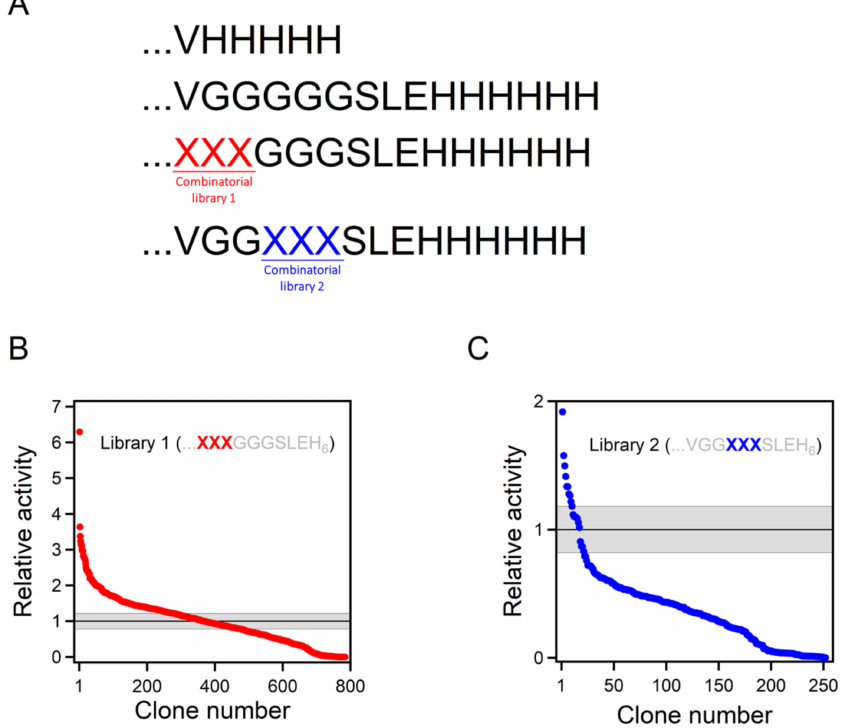
Figure 3. Combinatorial library screening for enhanced Kemp eliminase activity. ( A ) While the best Kemp eliminase from our previous work (34) had a VH 5 tail attached, the background variant used for library construction in this work had a VG 5 SLEH 6 polypeptide attached to the carboxyl terminus. Two 8000-variant combinatorial libraries were prepared, including all possible combinations of the 20 amino acids at two sets of three positions (labelled XXX), as shown. ( B , C ) The result of the screening of the two libraries. Clones are ranked according to Kemp eliminase activity relative to the background variant. The grey strip represents the average activity of the background variant plus or minus the associated standard